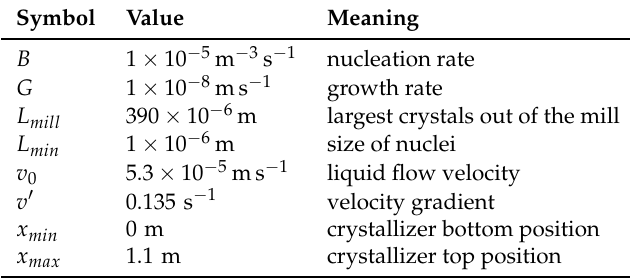
Table 1. Parameter values used in the simulations. The same nucleation rate B and growth rate G are assumed for both the desired enantiomer and the counter-enantiomer.